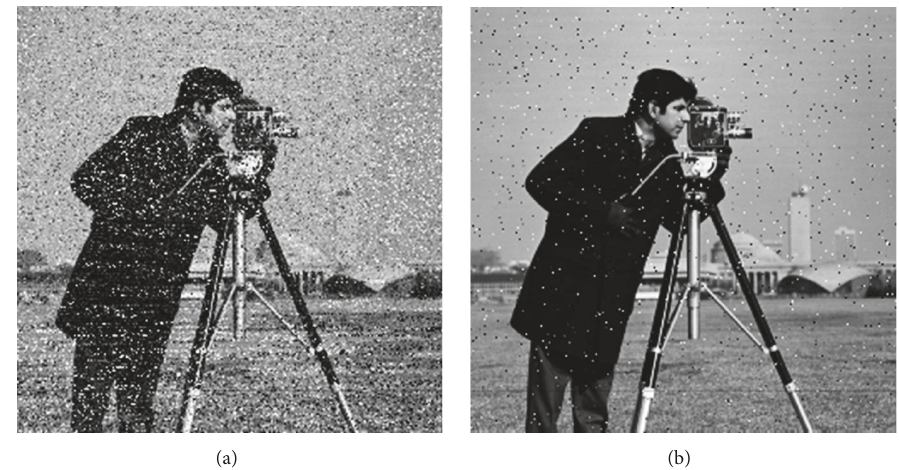
Figure 15: Decrypted images: (a) attacked by Gaussian noise and (b) attacked by salt-and-pepper